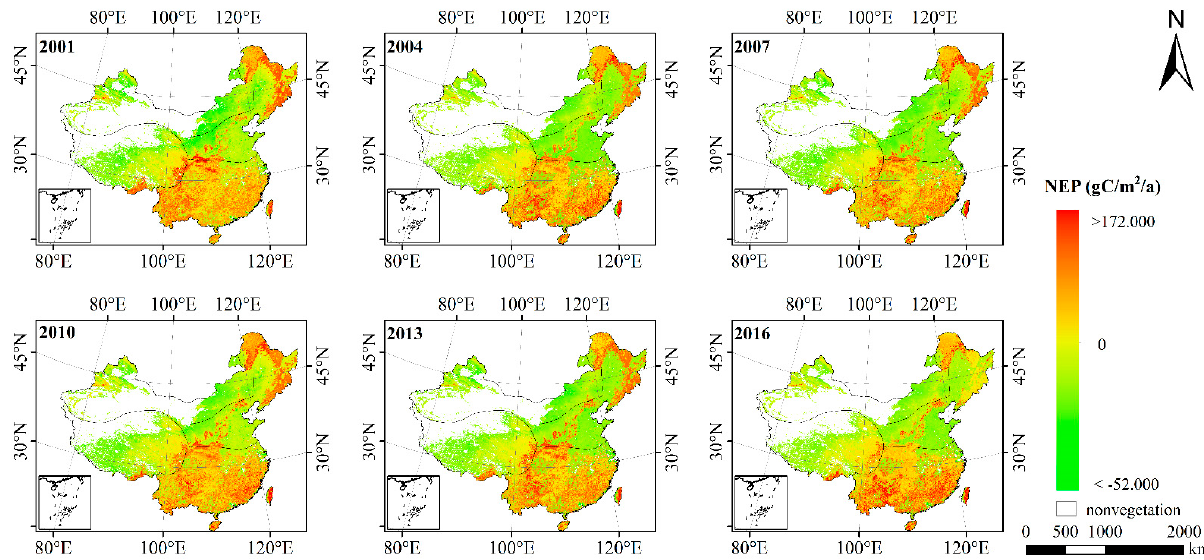
Figure 8. Average NEP in summer of China from 2001 to 2016.